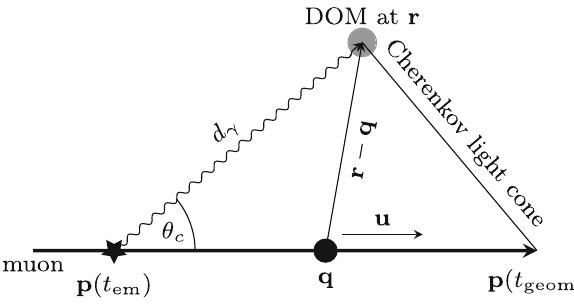
Fig. 5 Detailed geometry of a light cone created by a track. q is the position of the anchor point and r is the position of the optical module. p ( t em ) and p ( t geom ) are the positions of the muon at the time the photon is emitted and when it is geometrically expected to arrive,